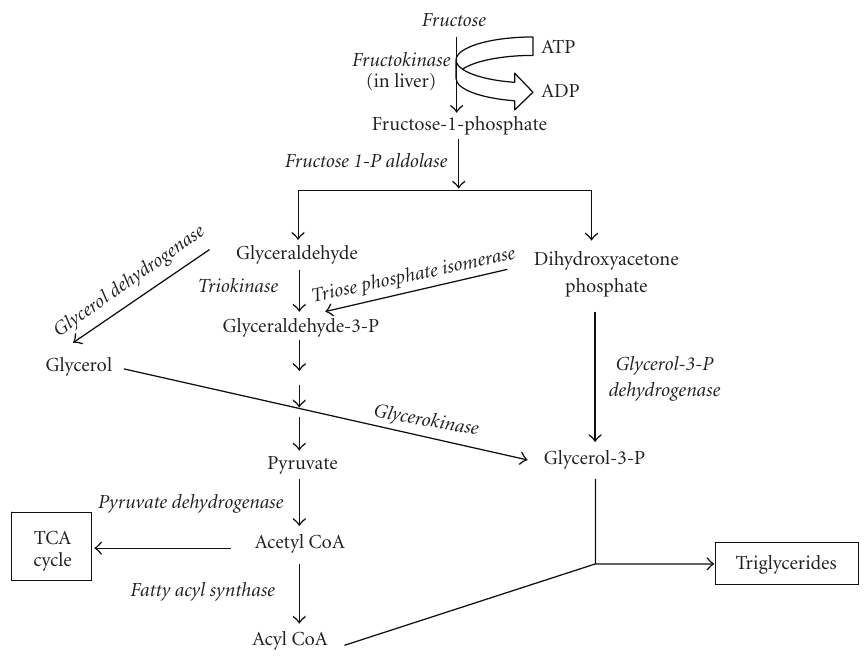
Figure 3: Metabolism of